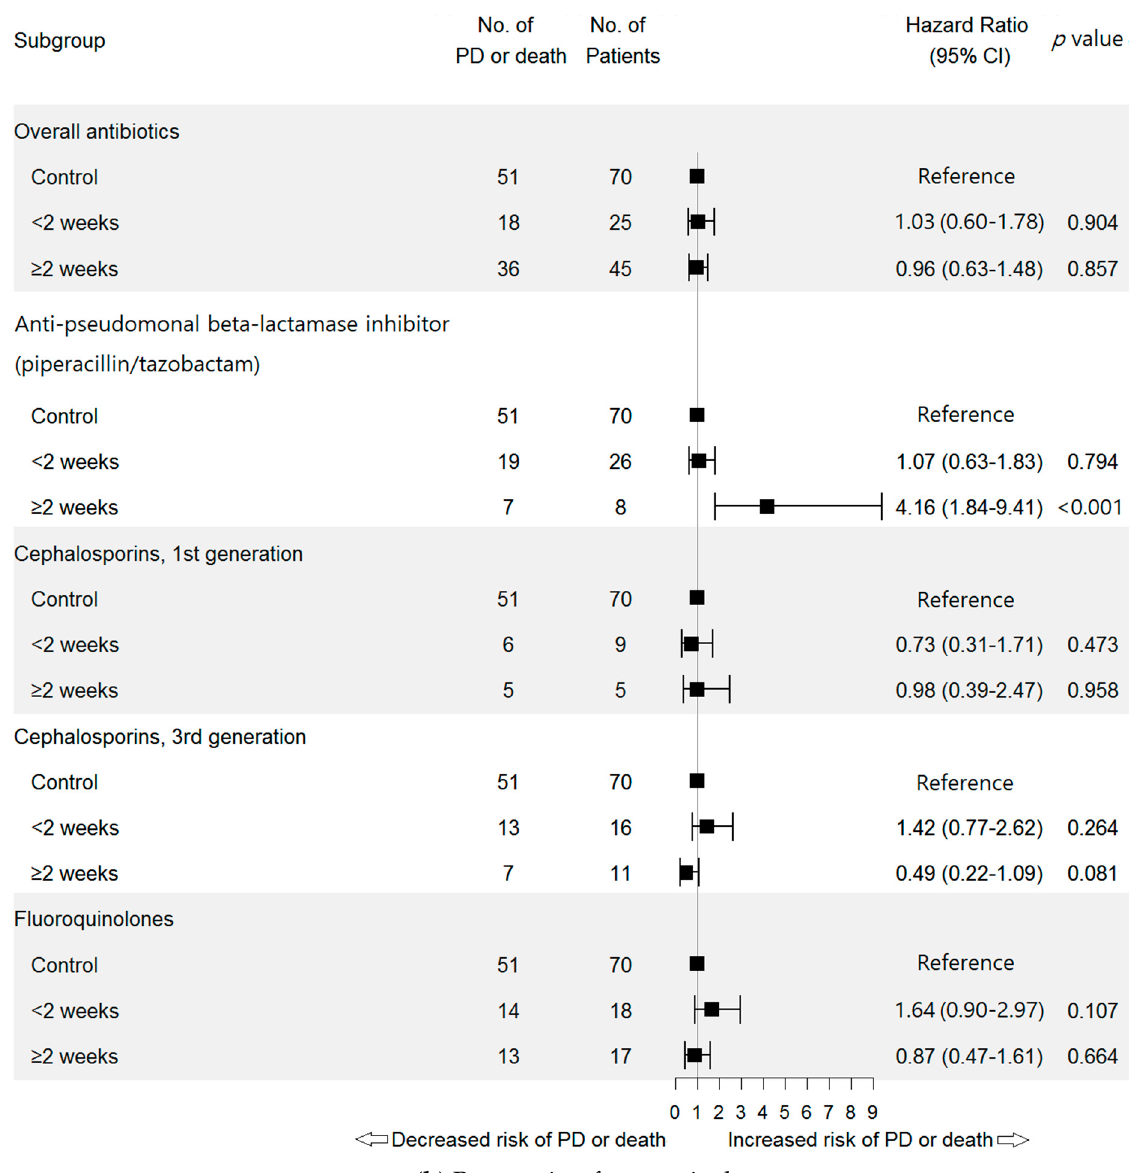
Figure 3. Hazard ratios for overall survival ( a ) and progression-free survival ( b ) by antibiotic days of therapy (DOT). Each control refers to the patients who have not used antibiotics (NoABX). Anti-tuberculosis medications, beta-lactamase inhibitors, carbapenem (meropenem), second-generation cephalosporins, fourth-generation cephalosporin (cefepime), glycopeptides, imidazole (metronidazole), macrolides, sulfamethoxazole/trimethoprim and tetracycline (doxycycline) were not included in this forest plot due to small sample sizes (<5). Abbreviations: No., number; PD, progression of disease.